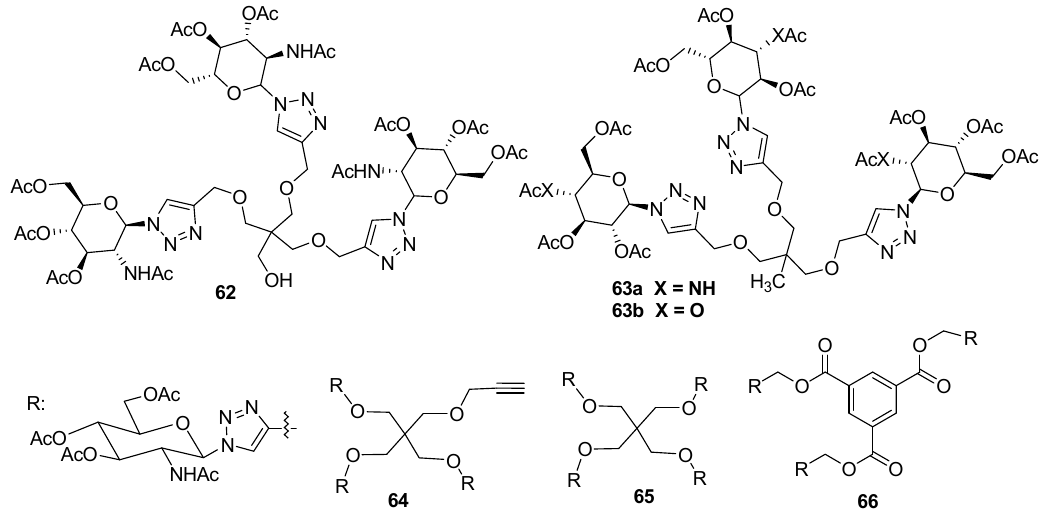
Figure 42. Structures of several glycoclusters that are effective LMWGs [87][88].